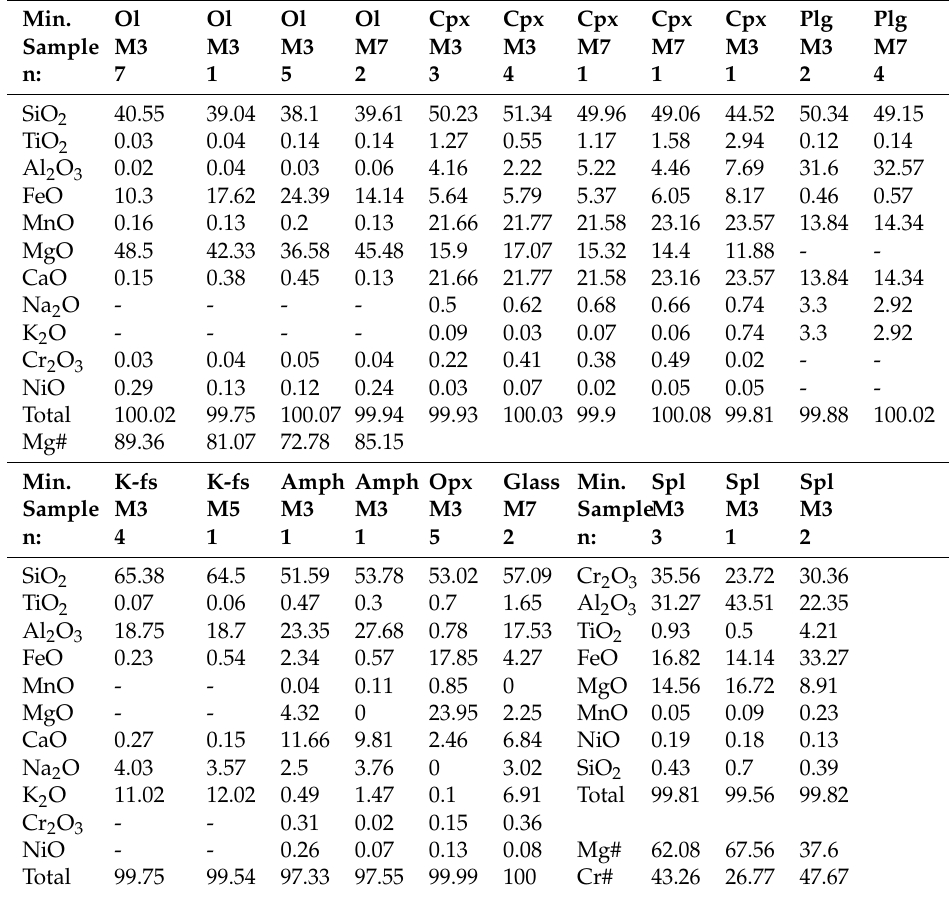
Table 1. Representative mineral chemistry analyses. (Abbreviations: Ol: olivine, Cpx: clinopyroxene, Plg: plagioclase, K-fs: K-feldspar, Amph: amphibole, Opx: orthopyroxene, Spl: spinel, n: number